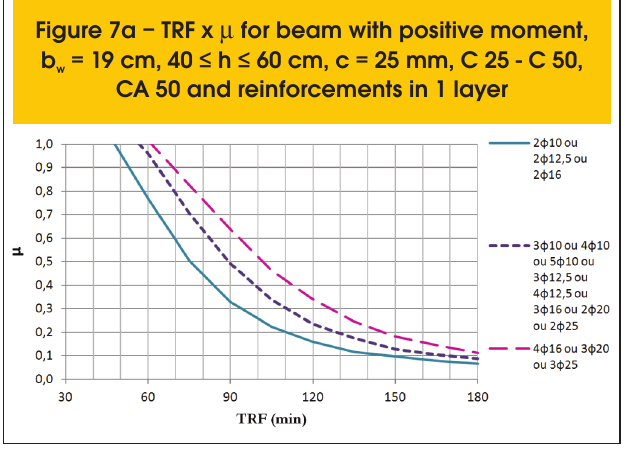
Figure 7b – TRF x m for beam with positive moment, b = 19 cm, 40 ≤ h ≤ 60 cm, c = 30 mm, w C 25 - C 50, CA 50 and reinforcements in 1 layer